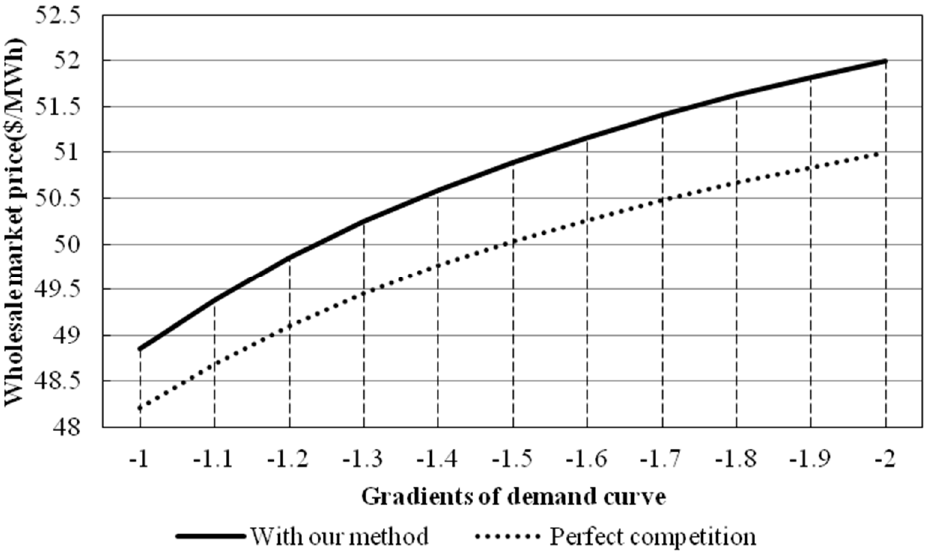
Figure 4. Market-clearing price with perfect competition and with the method described